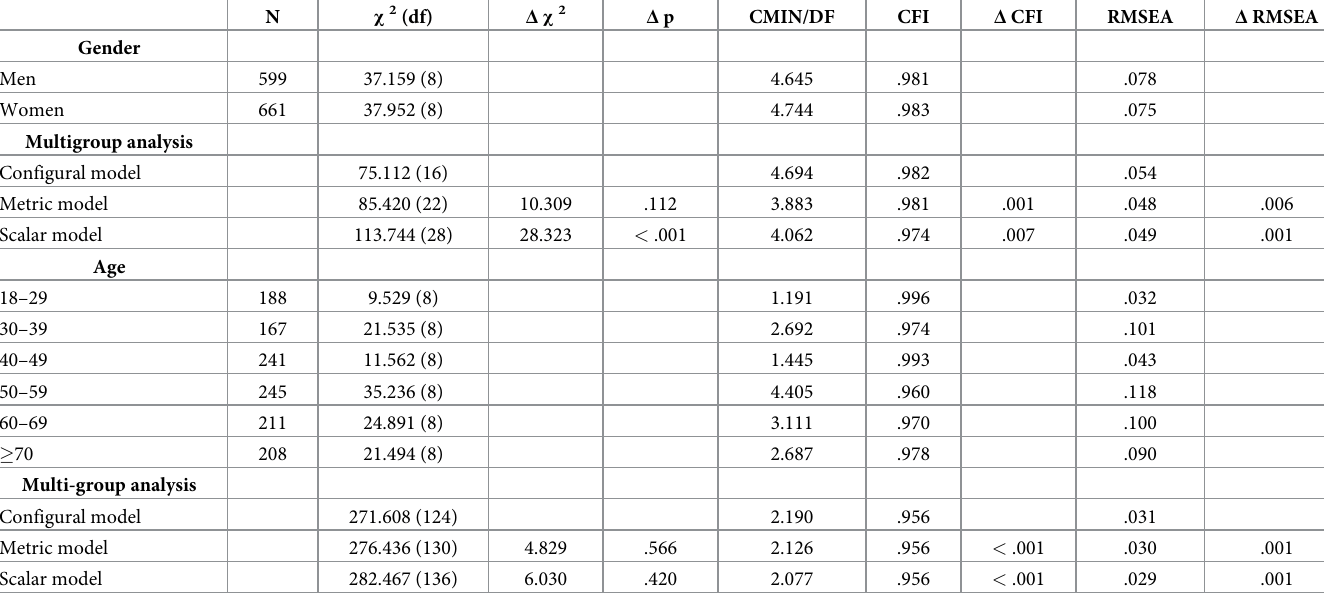
Table 6. Tests for invariance across gender and age